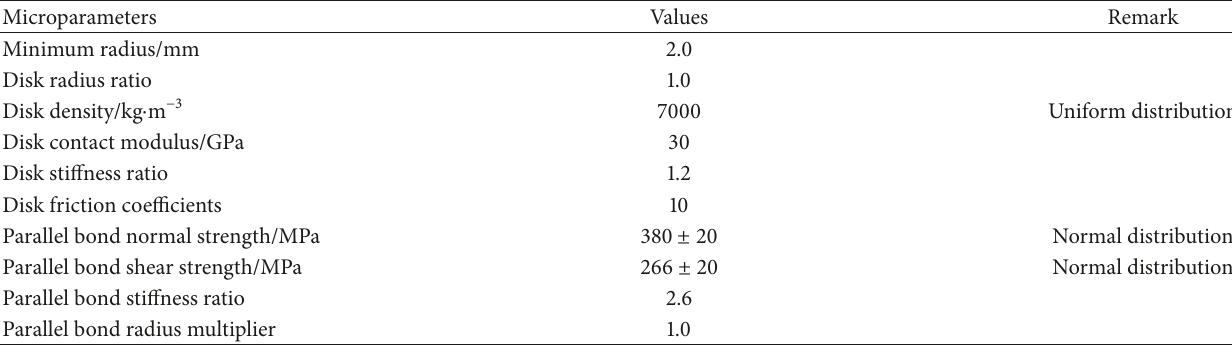
Table 2: Microparameters of the